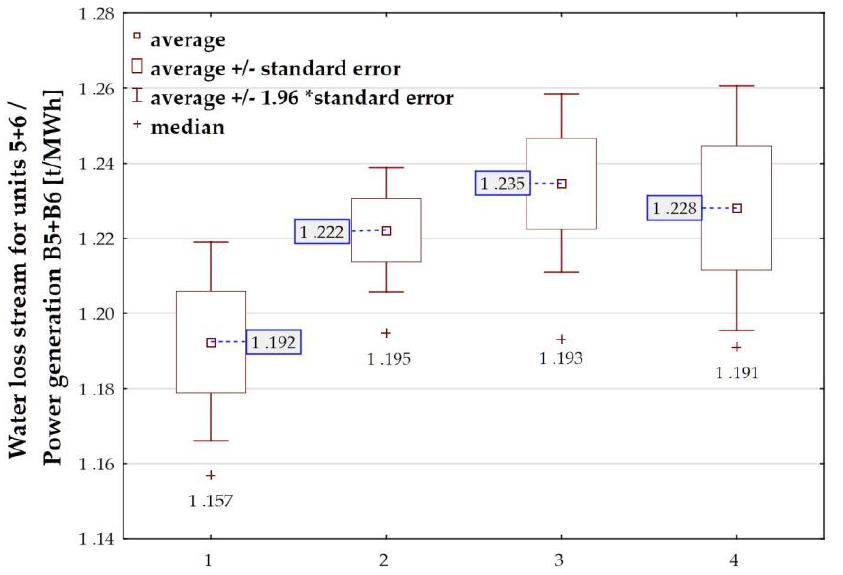
Figure 11. The effect of wind velocity on the total water evaporative loss in relation to the instanta- neous power of the power units. Source: own elaboration (Statistica software).